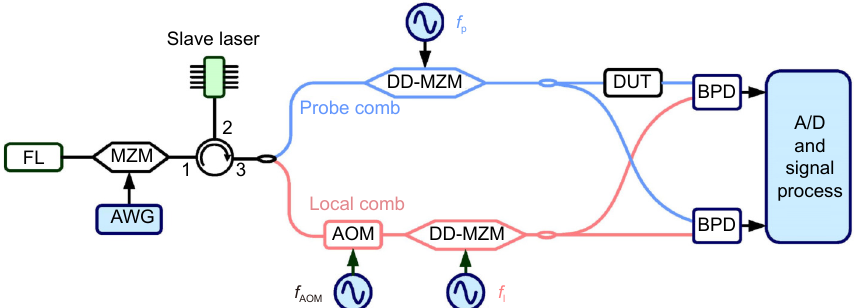
Fig. 2 | Experimental setup of the proposed EO-DCS system. FL: fiber laser; MZM: Mach-Zehnder modulator; AWG: arbitrary waveform gen- erator; AOM: acousto-optic modulator; DDMZM: dual-drive Mach-Zehnder modulator; DUT: device under test; BPD: balanced